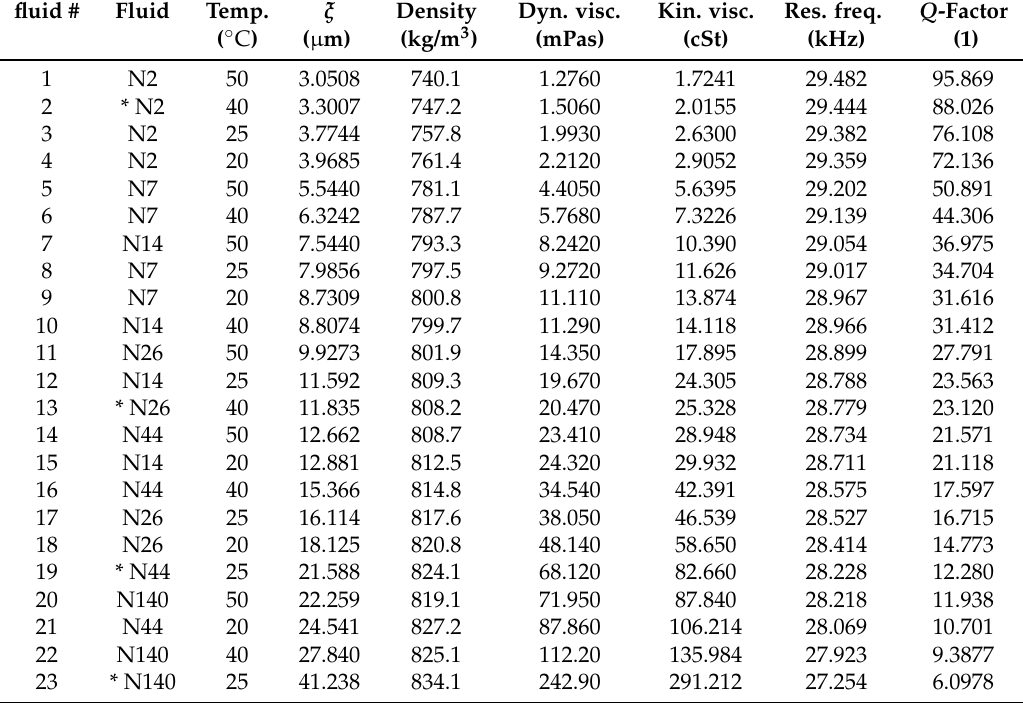
Table 1. Table of standard fluids in ascending order of ξ and the associated measured resonance parameters. The fluids used for model calibration are marked by ∗